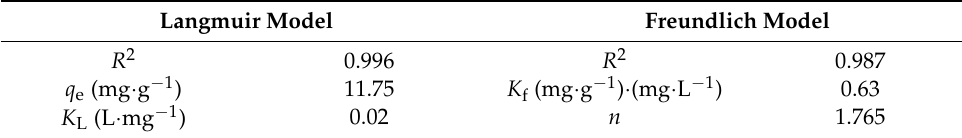
Figure 4. Adsorption isotherm of UiO-66 (pH = 3, t = 24 h, m (UiO-66) = 10 mg, V (solution) = 20 mL and T = 298.15K). Table 2. Parameters of isotherm models for UiO-66.